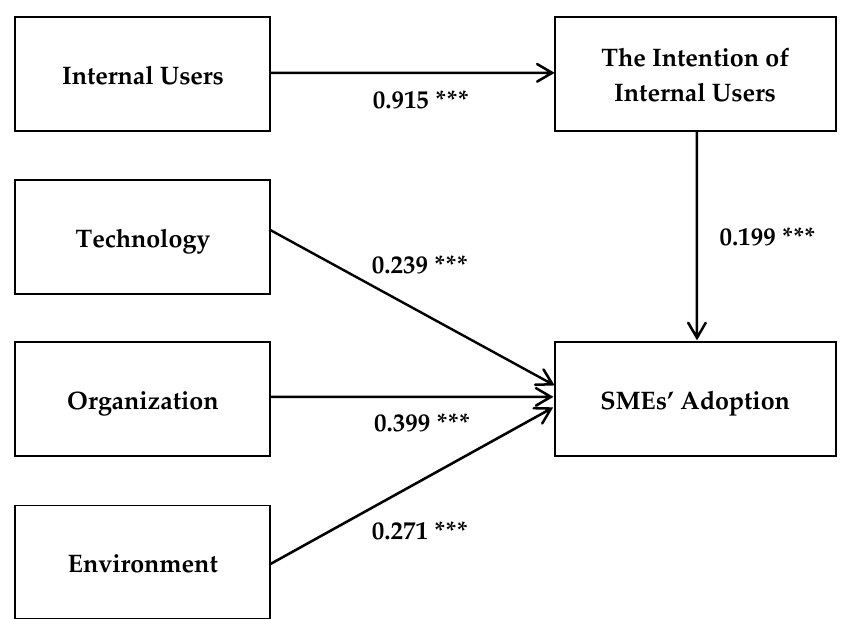
Figure 3. Results of structural modeling analysis. Path coefficients and p -values, the significance is indicated by stars (*** p -value < 0.001).